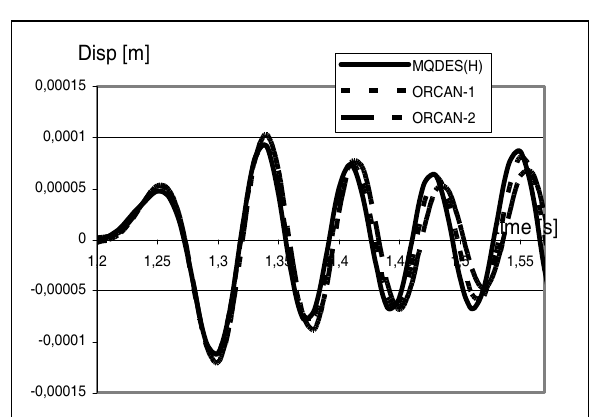
Fig 11 . Displacements diagram of the segment top in v